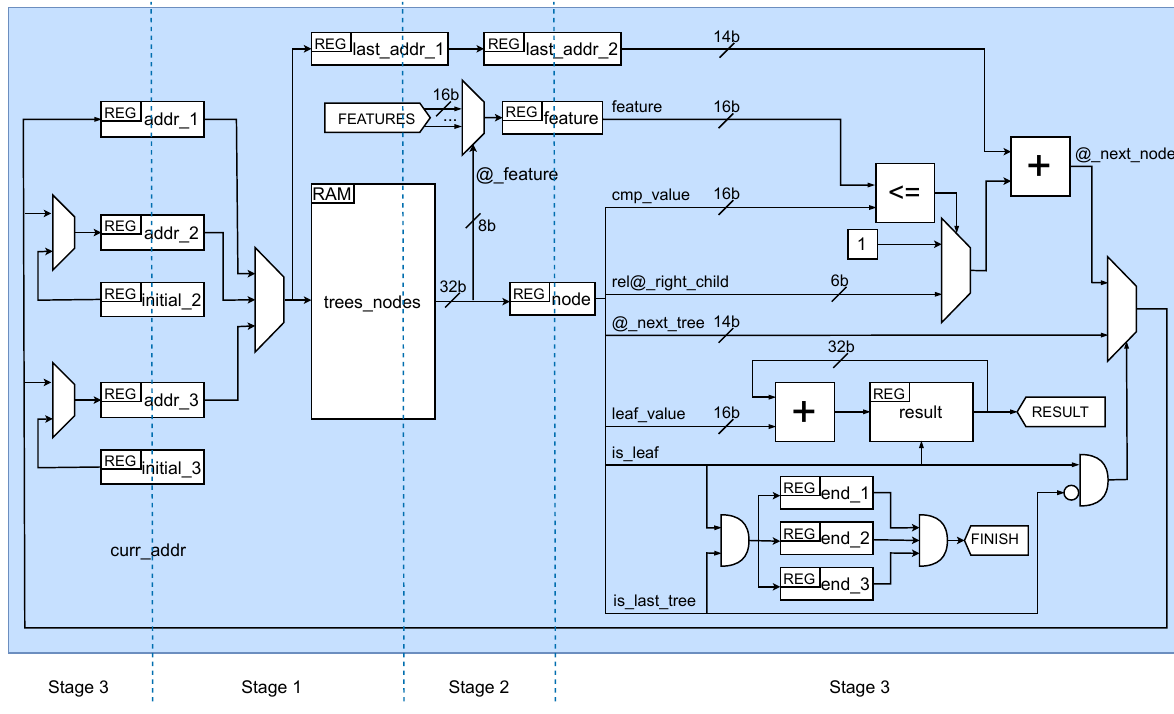
Figure 9. Multi-threading class